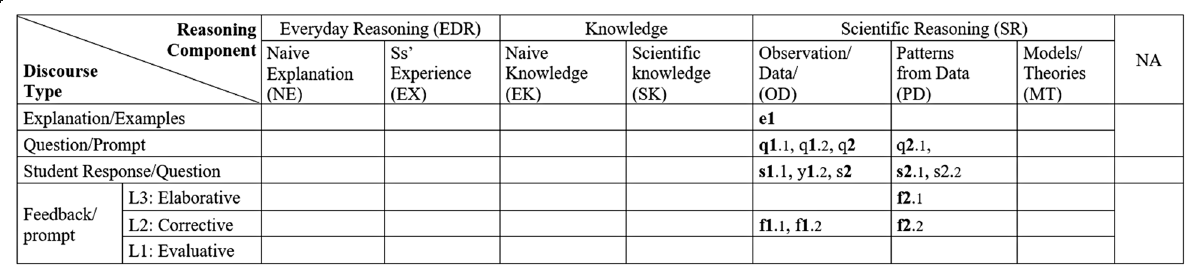
Fig. 6 Cory ’ s CDAT table coded and the dialogs